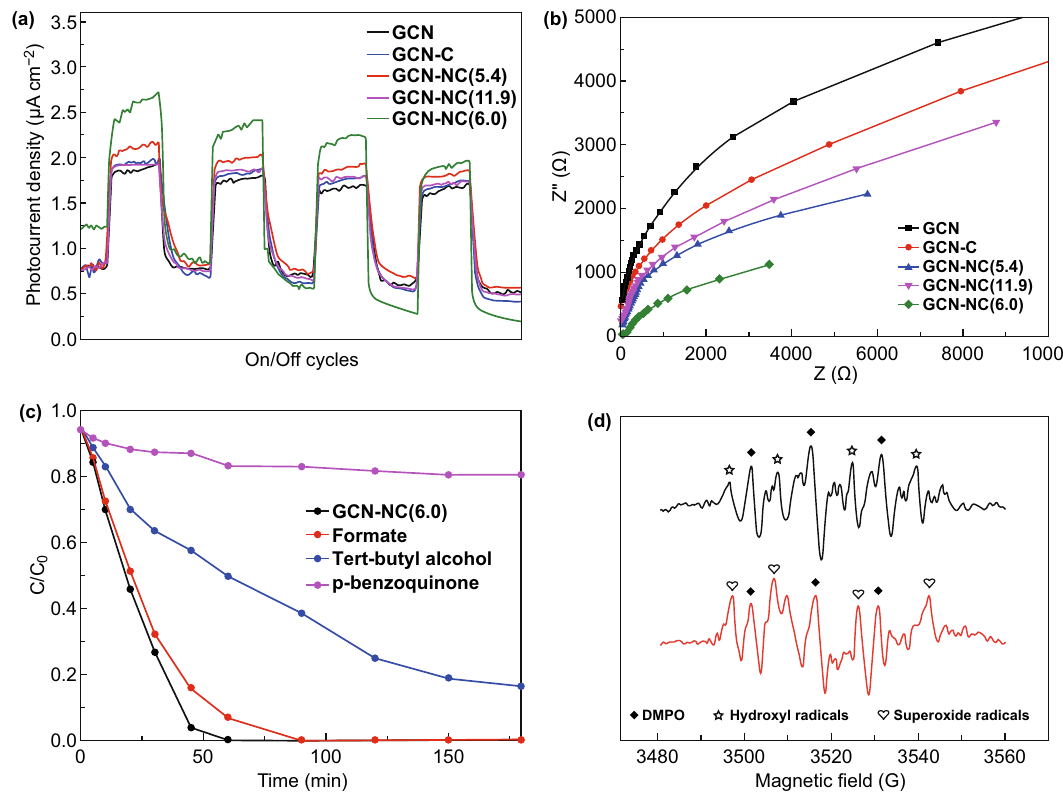
Fig. 5 a Transient photocurrent and b EIS curves of the GCN, GCN-C, GCN-NC(5.4), GCN-NC(11.9), and GCN-NC(6.0) in 0.1 M Na 2 SO 4 solution. c Photocatalytic activity of GCN-NC(6.0) for SCP degradation with radical scavengers (formate, tert-butyl alcohol, and p-benzoqui- none) under visible light irradiations. d EPR spectra of GCN-NC(6.0) under UV–visible light irradiations with quenching of tert-butyl alcohol and